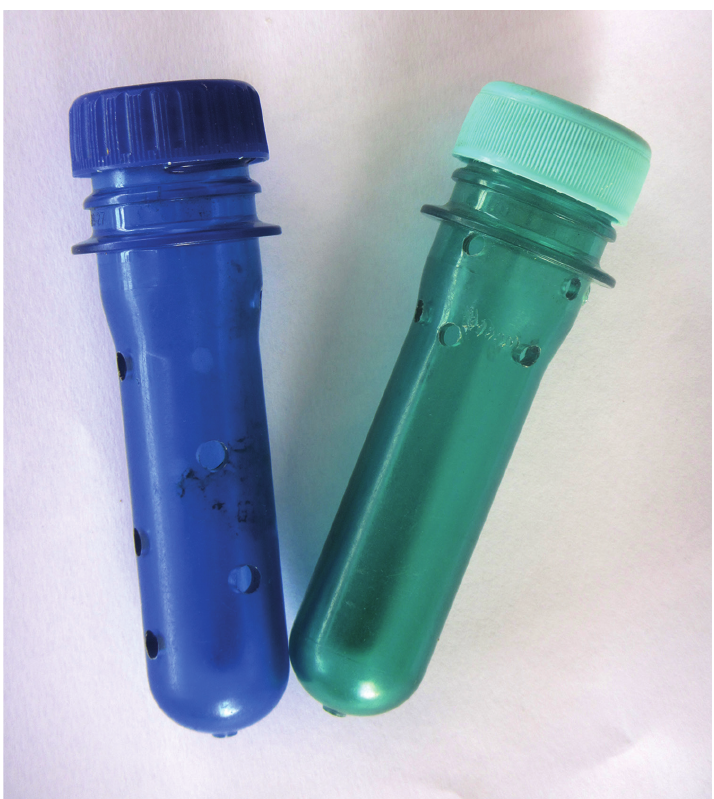
Figure 2. Perforated vials in which the larvae were inserted to protect them during training (Photo by Fabio